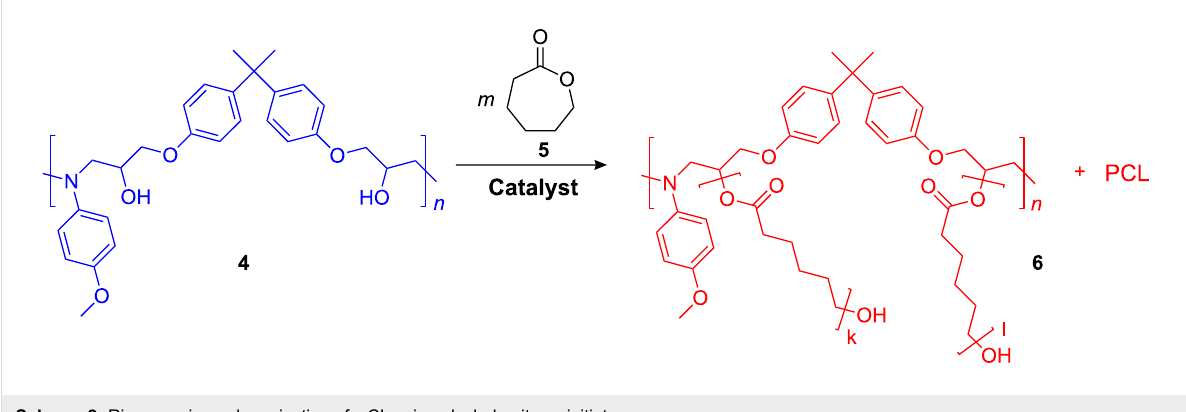
Scheme 2: Ring-opening polymerization of ε -CL using alcohol units as initiator.